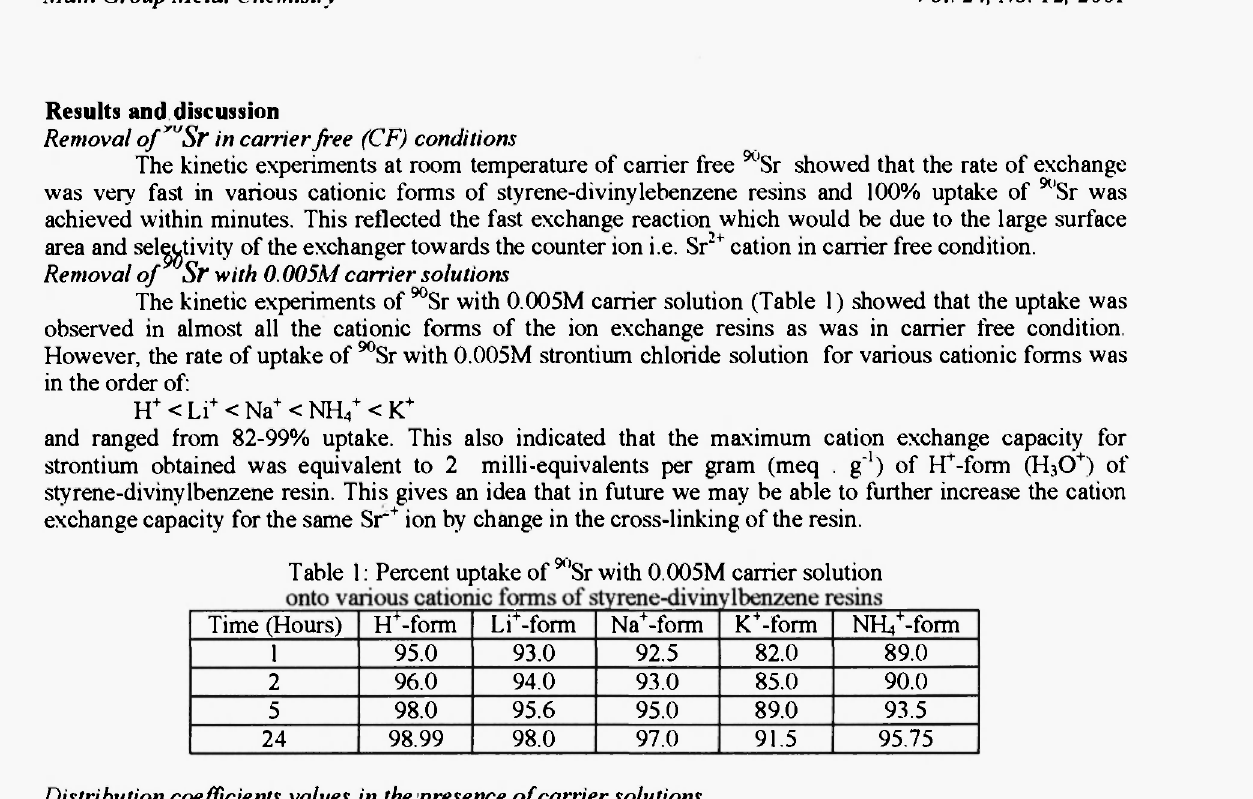
Table 1: Percent uptake of ''"'Sr with 0.005M carrier solution